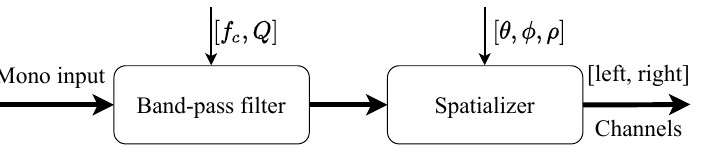
Figure 4. DSP in the audio thread. Mono input signals coming from audio files are first band-pass filtered and then spatialized, creating a stereo signal that is sent to the audio buffer in